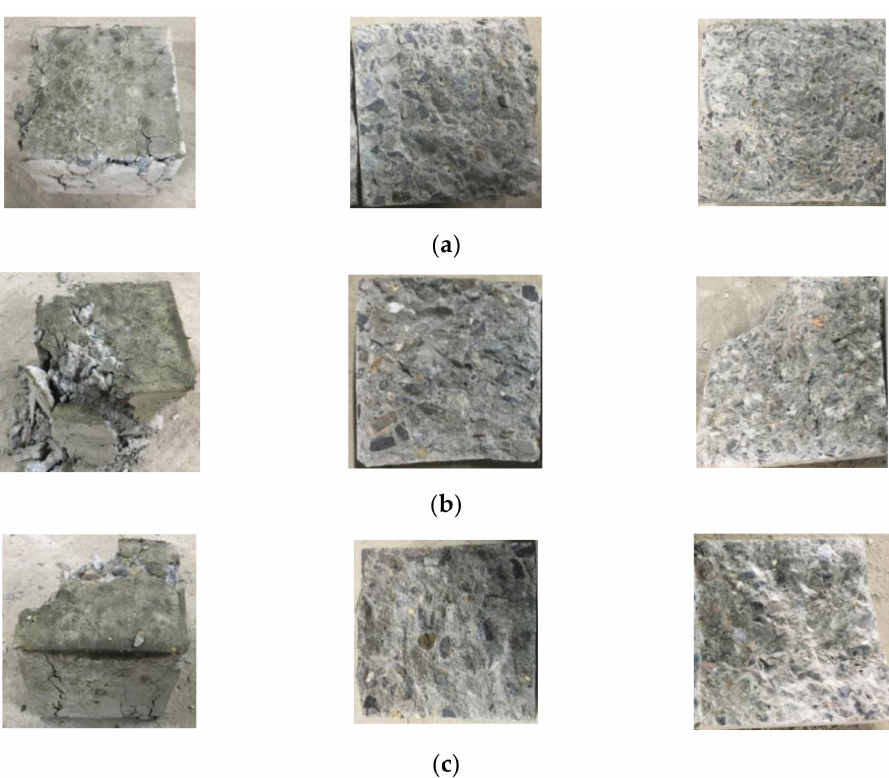
Figure 3. Basic failure modes of recycled aggregate concrete with different substitution ratios (from left to right are the results of compression, tensile and shear loading tests): ( a ) 0% substitution ratio of recycled aggregate; ( b ) 50% substitution ratio of recycled aggregate; and ( c ) 100% substitution ratio of recycled